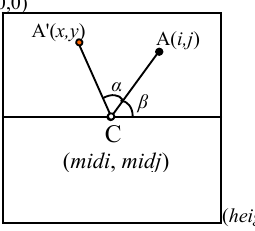
Fig. 3. Rotating an